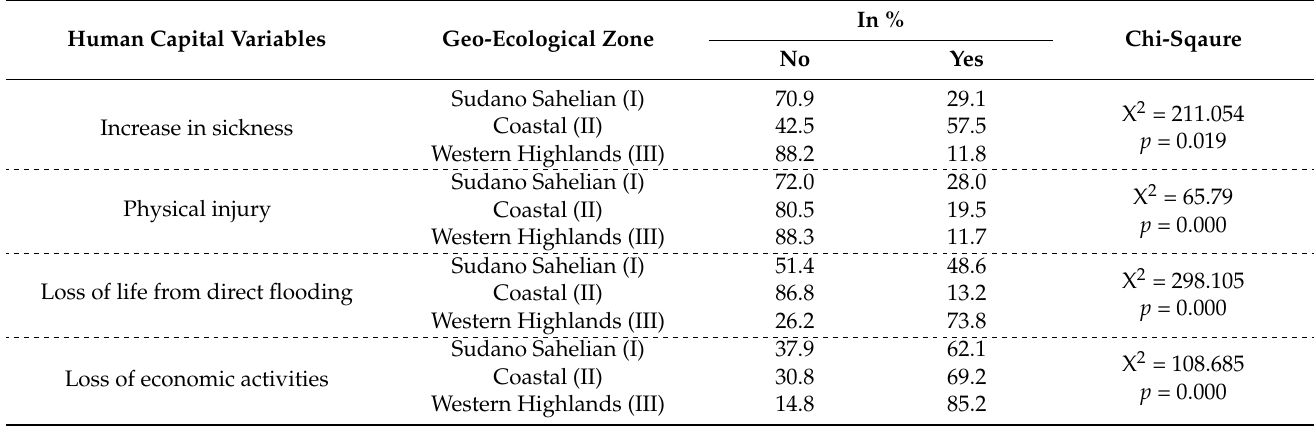
Table 2. Flood effect on human